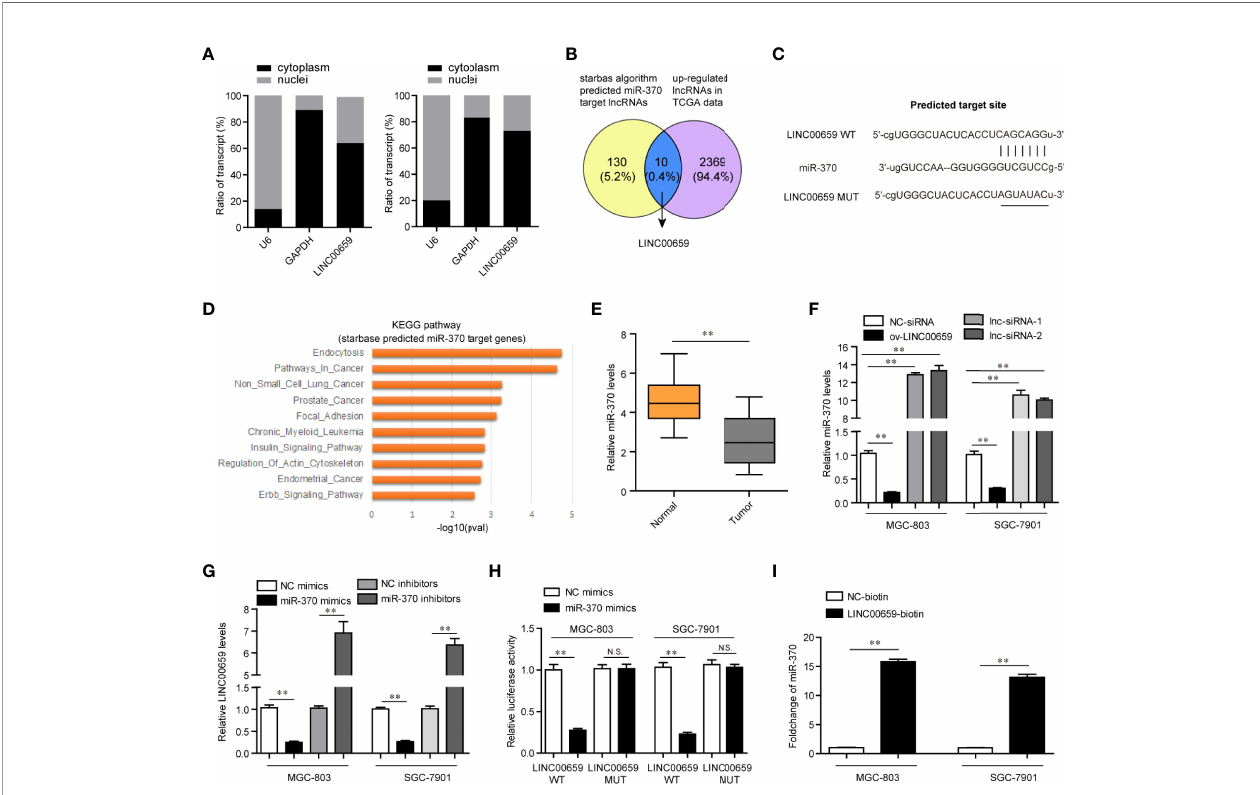
FIGURE 5 | MiR-370 was a target of LINC00659. (A) Subcellular fractionation assays. (B) The intersection of the predicted miR-370 target lncRNAs and up- regulated lncRNAs in GC tumor specimens. (C) “ starbase ” algorithm predicted the binding site between LINC00659 and miR-370. (D) KEGG pathway analysis using the “ starbase ” algorithm predicted miR-370 target genes. (E) qPCR analyses detected miR ‐ 370 expression in 120 GC samples. (F) qPCR measured miR ‐ 370 levels in GC cells after various treatment. (G) qPCR measured LINC00659 levels in GC cells after various treatment. (H) Luciferase activity detection. (I) RNA-pull down assays. **P < 0.01. N.S., no signi fi